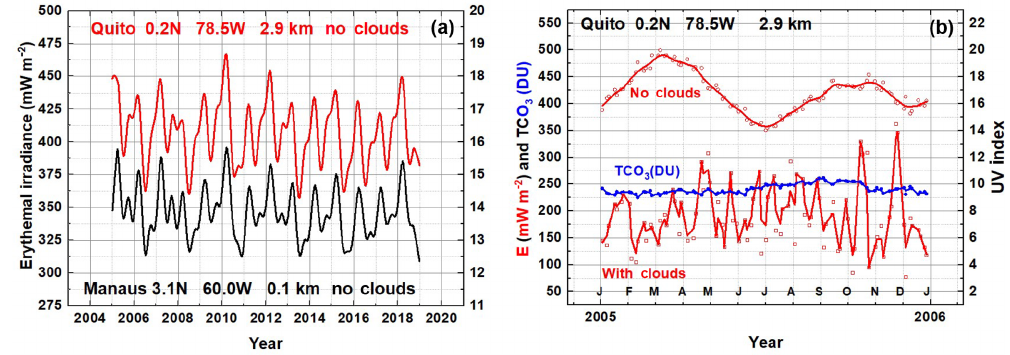
Figure 5. (a) A 2-week running average of cloud-free E(ζ,ϕ,z,t) corresponding to the data in Fig. 3a for Quito, Ecuador, and Manaus, Brazil, showing the effect of height and a small difference in average ozone amount. (b) An temporal expansion for 1 year (2005) of E(ζ,ϕ,z,t) estimates for Quito showing the double peak as a function of minimum SZA near the equinoxes in the absence of clouds that is masked when clouds are included. The blue line shows the 20DU variation in ozone between March and September. Solid lines in panel (a) are an Akima spline